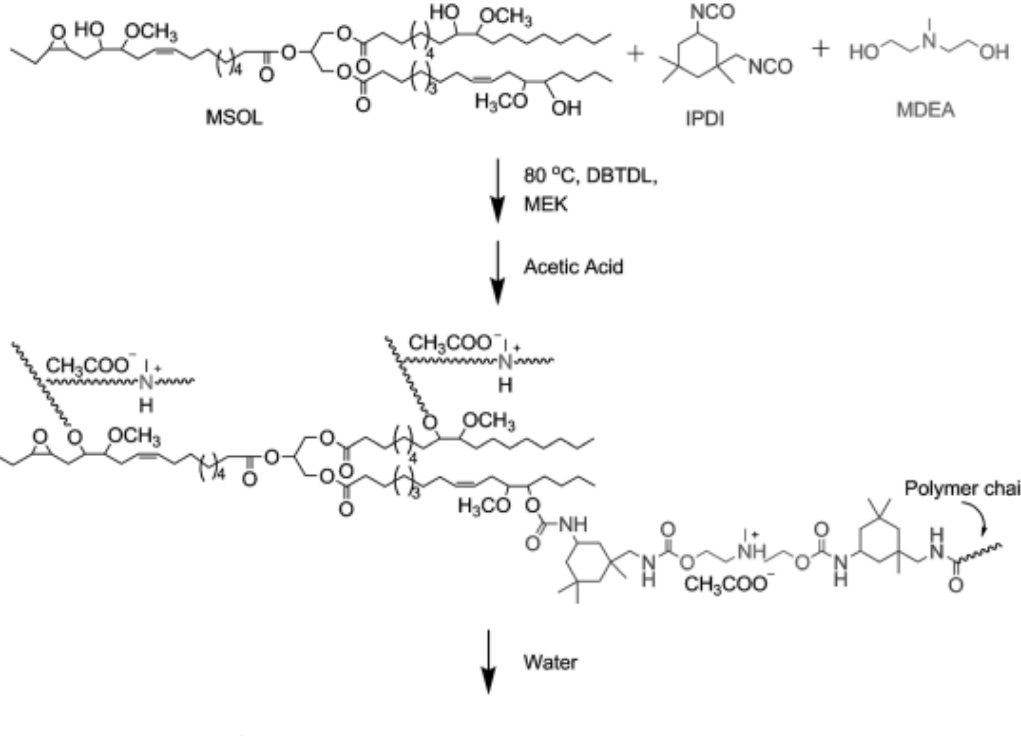
Figure 3. Reaction scheme of the cationic plant-oil based polyurethanes (reproduced with permission from [70]).